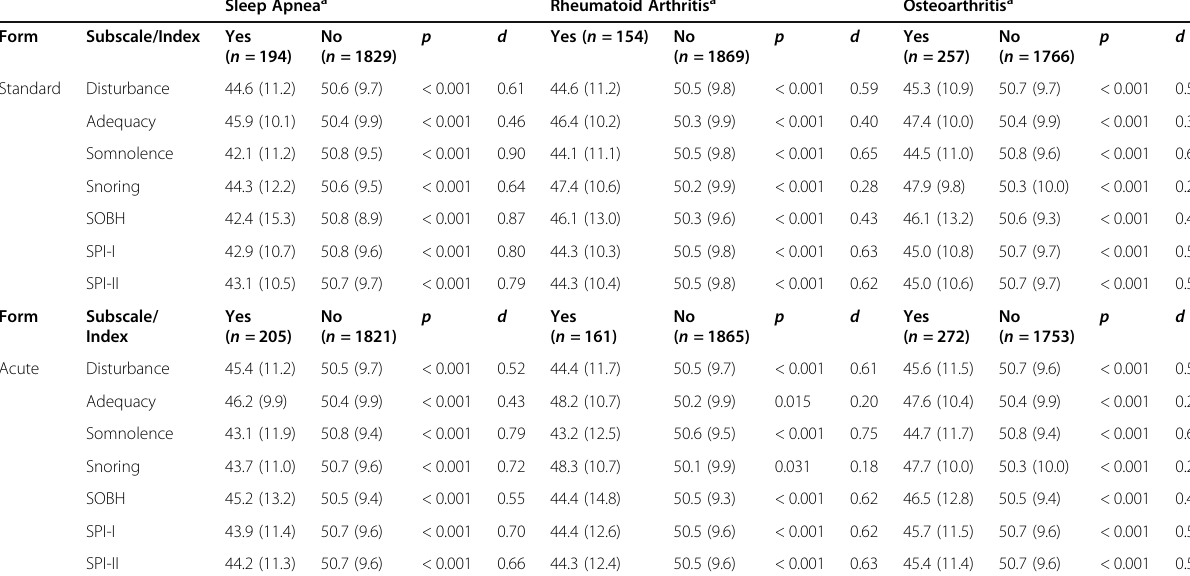
Table 8 Differences in mean MOS Sleep-R scores as a function of self-reported health condition Rheumatoid Arthritis a Osteoarthritis